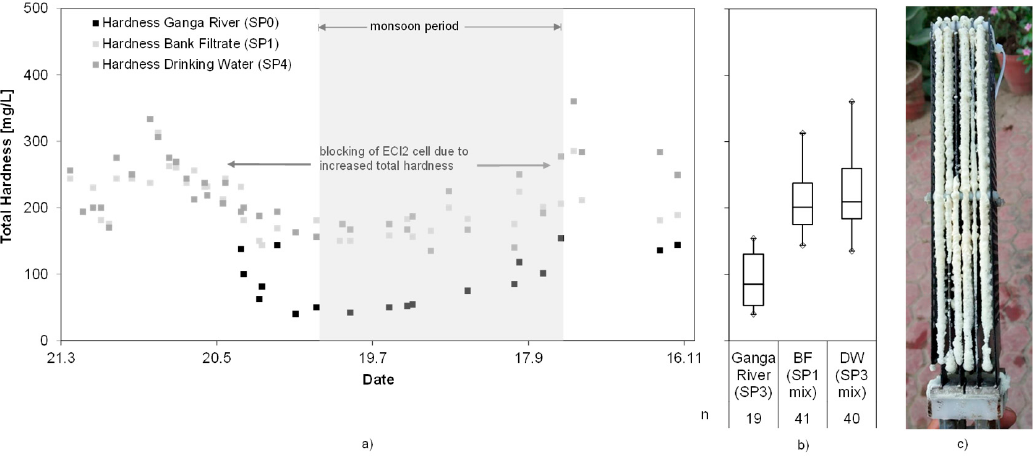
Figure 11. Total hardness values in SP0 and SP1 during the first long term test ( a , b ); and calcareous deposits on the ECl 2 -cell ( c ).